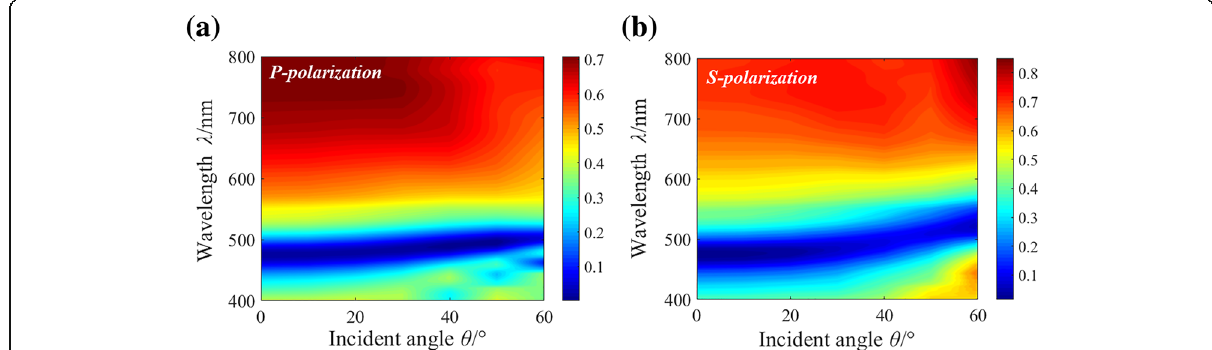
Fig. 4 Contour map of the simulated angle-resolved reflectance spectra for the structure with P = 180 nm, D = 80 nm under a p -polarized and b s -polarized illumination